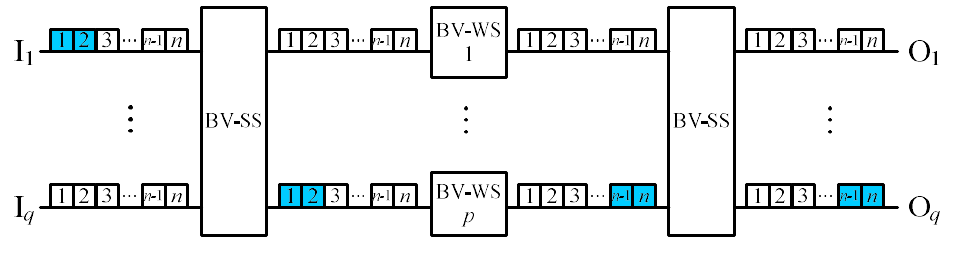
Figure 1. An SWS1( q , p , n ) switching fabric.